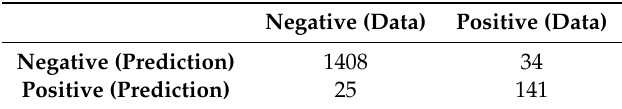
Table 4. Confusion matrix of the MLP model for a representative out of the five folds (test